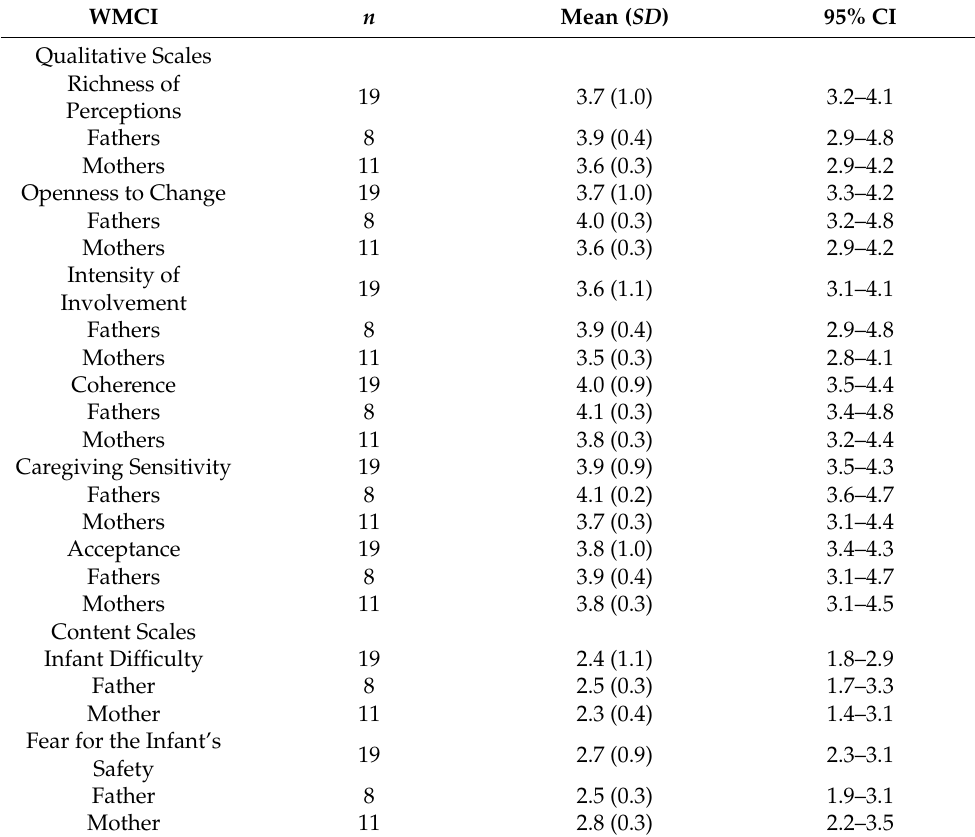
Table 3. Mean scores of the Qualitative and Content Scales of the Working Model of the Child Interview (WMCI) measuring parents’ representations of their infants for the group and for the mothers and